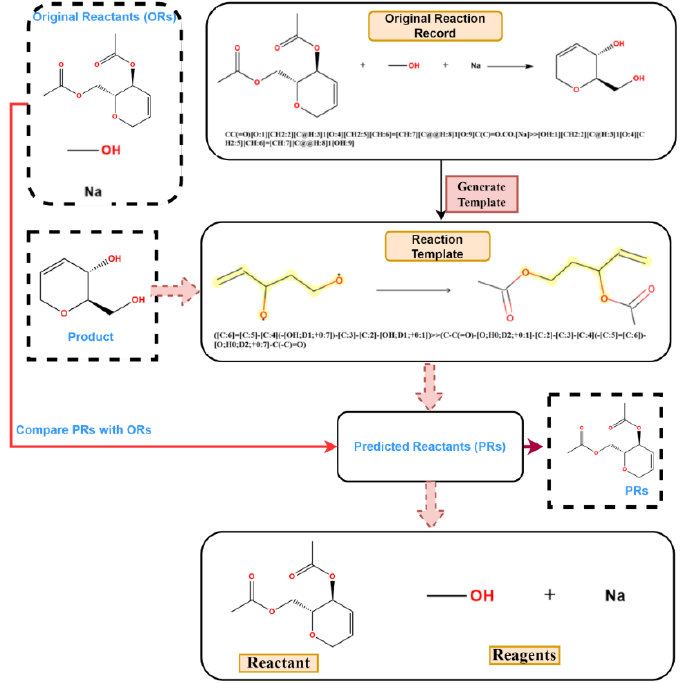
Figure 4. The process of role designation: (1) rearrange ORs; (2) generate inverse reaction templates; (3) match original product with inverse templates and get PRs; (4) compare PRs with ORs.